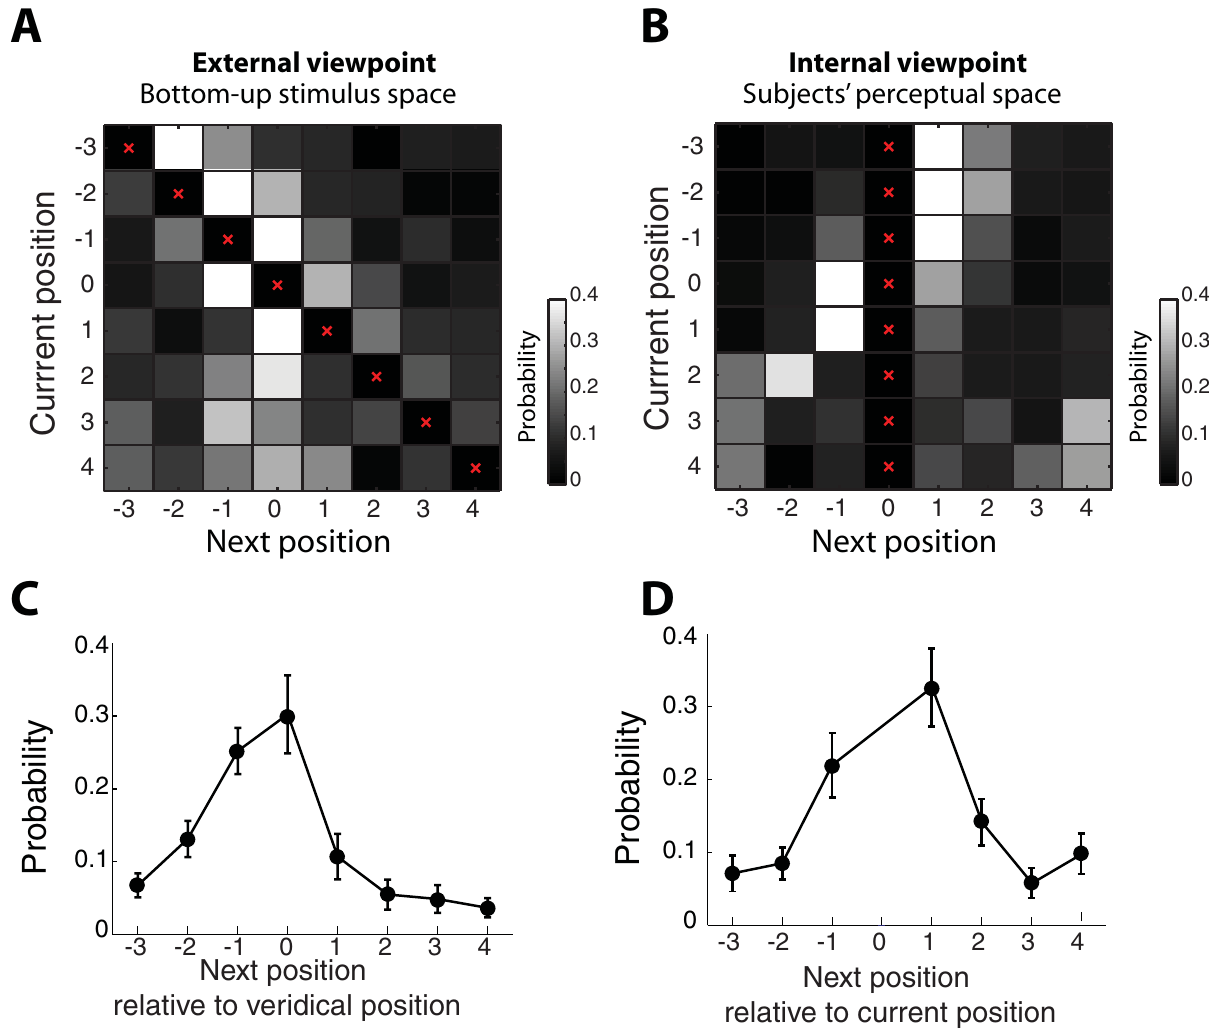
Figure 3. Characteristics of the group transition pattern. A . Transition probabilities are shown for all possible transition combinations. The diagonal elements signifying no perceptual shifts (red crosses) are not shown. B . The same data are represented relative to current position emphasize the directionality of the shifts. C . Transition probability marginalized across all current positions is plotted as a function of the absolute disk position. D . Transition probability marginalized across all current positions is plotted as a function of the relative disk position.